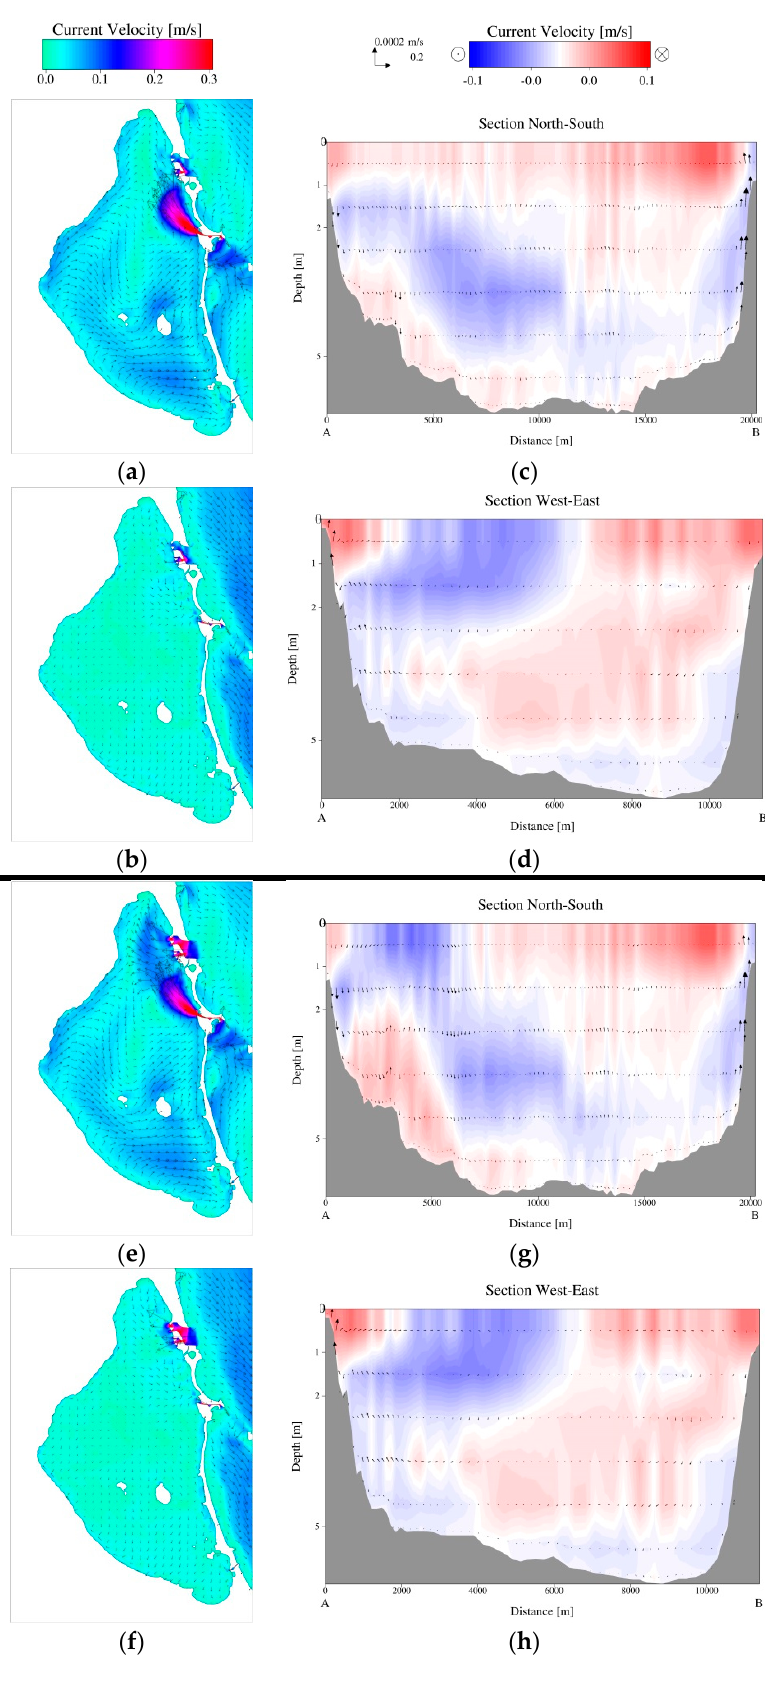
Figure 11. Current speeds at the Undisturbed ( top ) and Enc_1m ( bottom ) scenario on 21 ‐ 12 ‐ 2009 at 16 h (maximum flow inwards): surface ( a , e ) and bottom ( b , f ) layers/transects at North ‐ South ( c , g ) and West ‐ East ( d , h ) sections. (Red: outwards/Blue: inwards directions).